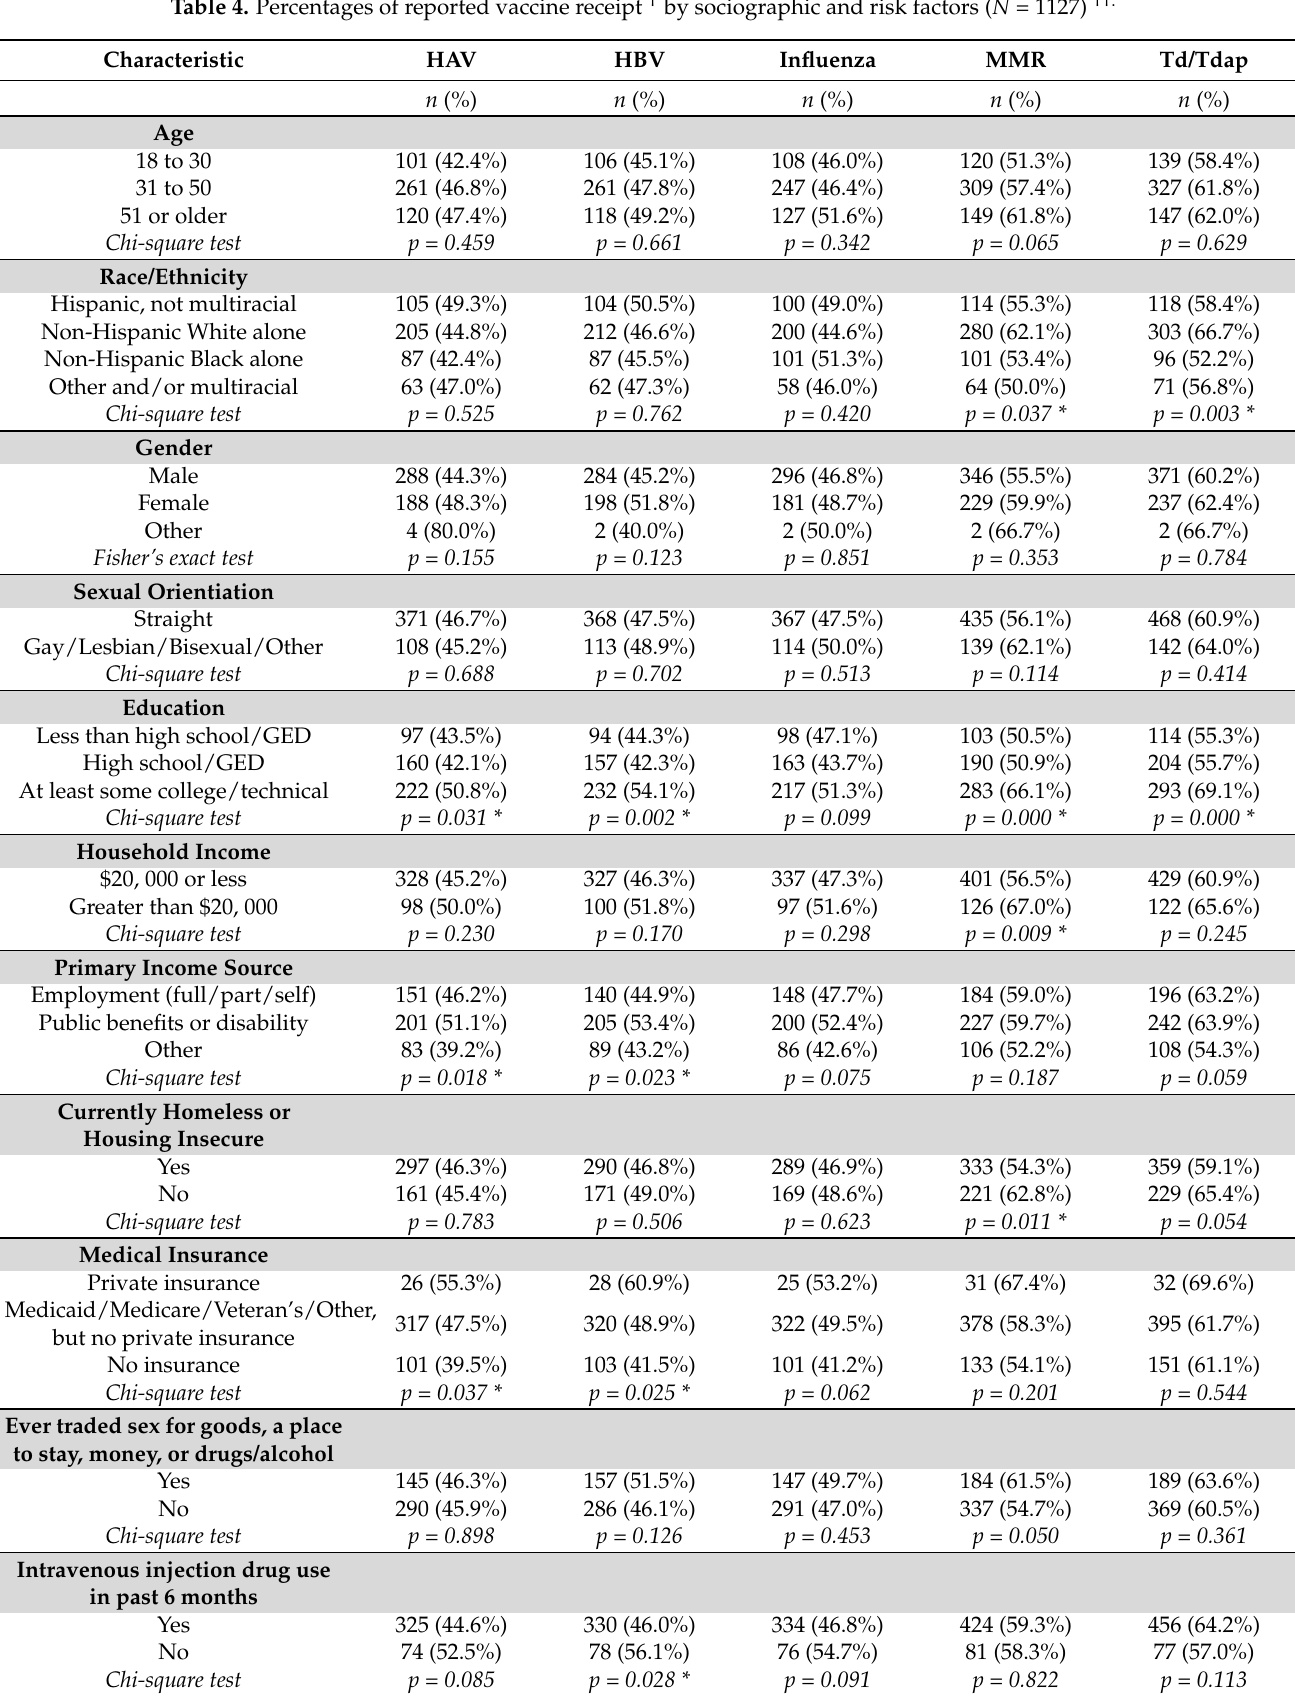
Table 4. Percentages of reported vaccine receipt † by sociographic and risk factors ( N = 1127) ††.